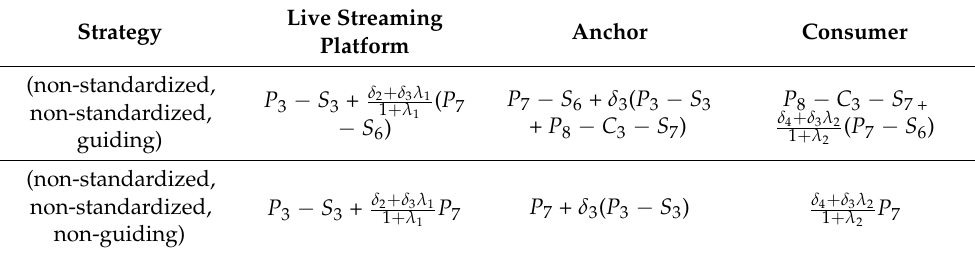
Anchor Consumer